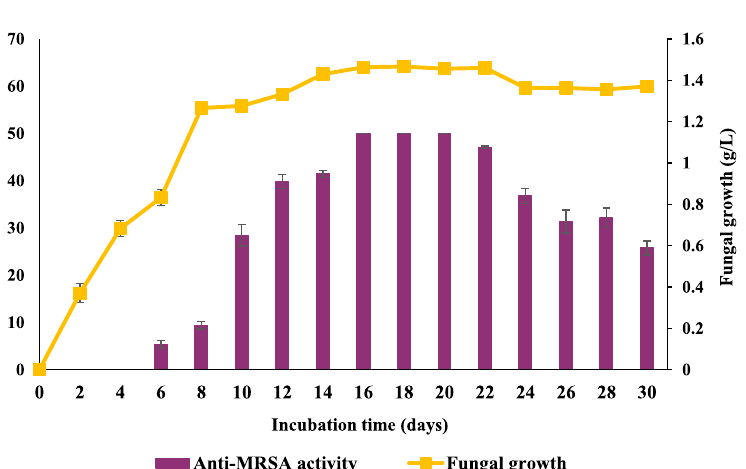
Fig. 8. Time course profiles of the anti-MRSA activity and fungal growth of L. pseudotheobromae IBRL OS-64 after improved conditions. Different letters indicate significant differences between means (Duncan, p<0.05). Standard deviation values of triplicate analyses are shown by error